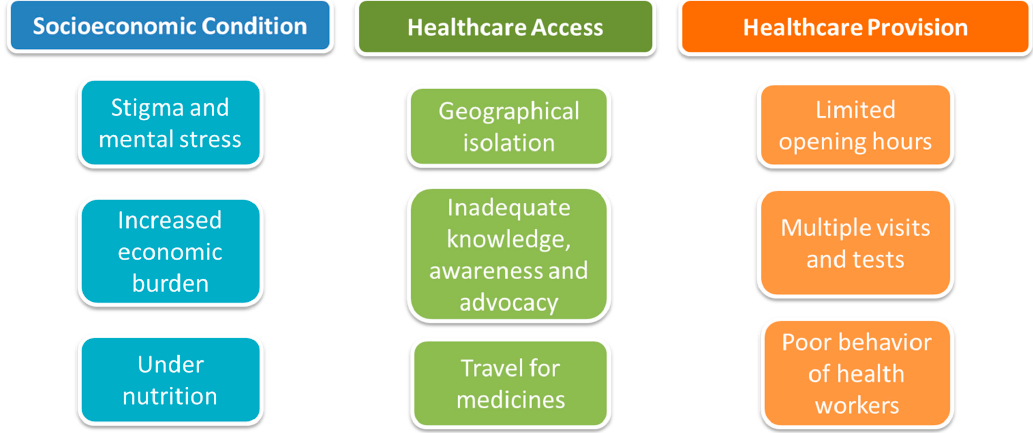
Figure 1. Perceived barriers to accessing and engaging with tuberculosis (TB) diagnosis and care.